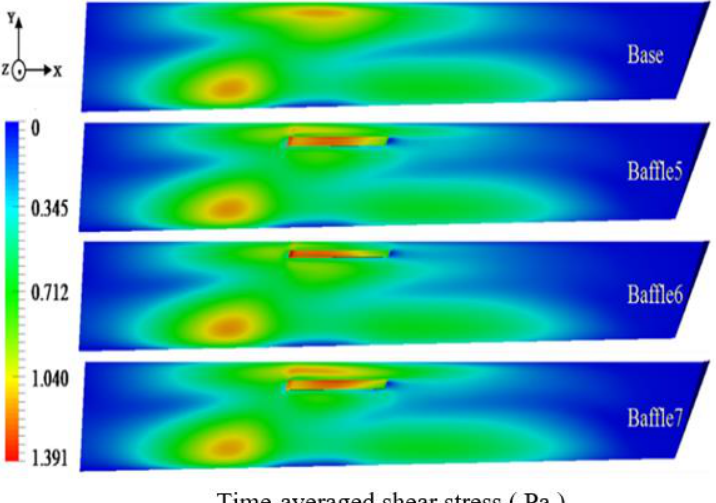
Figure 26. Time-averaged shear stress distribution on the sidewall of the main trough with different heights.